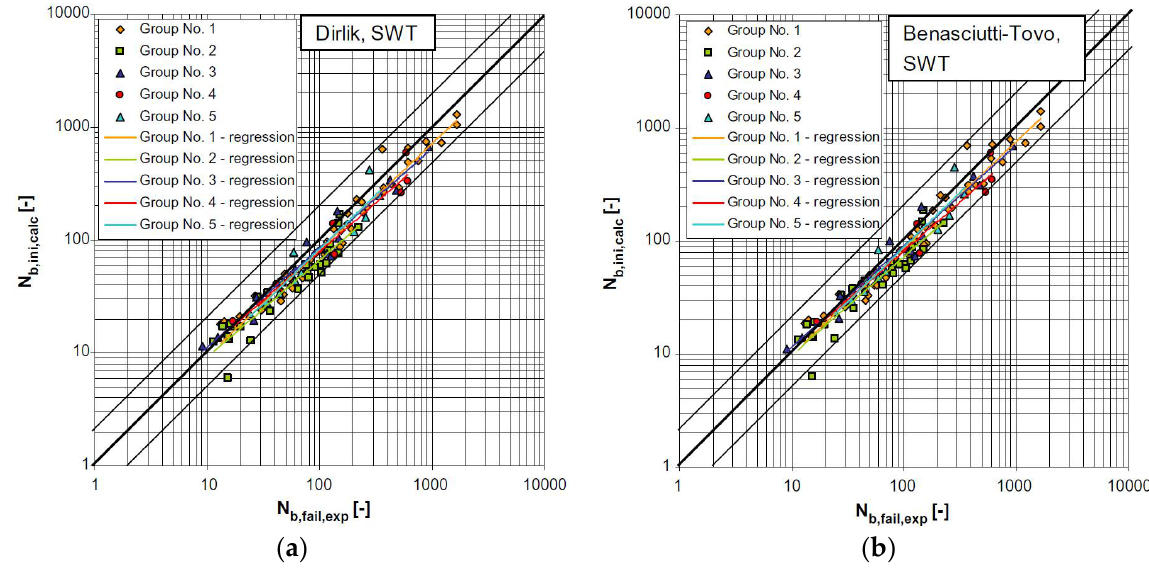
Figure 9. Example of comparison with experimental fatigue life presented in [80] for: ( a ) Dirlik method and ( b ) TB method. Reproduced from [80] with permission from Elsevier.